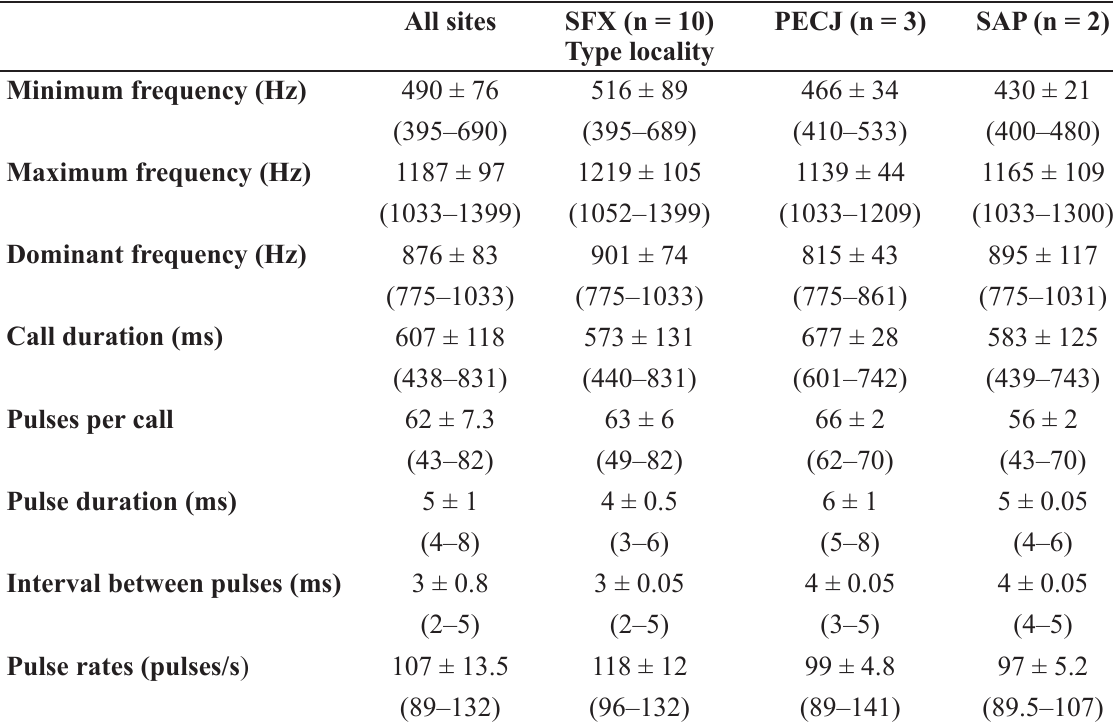
Table 4. Advertisement call parameters of Odontophrynus toledoi sp. nov. including sampled populations from the type locality São Francisco Xavier (SFX), Parque Estadual de Campos do Jordão (PECJ) and Santo Antônio do Pinhal (SAP). The results are presented as mean ± sd, minimum–maximum values